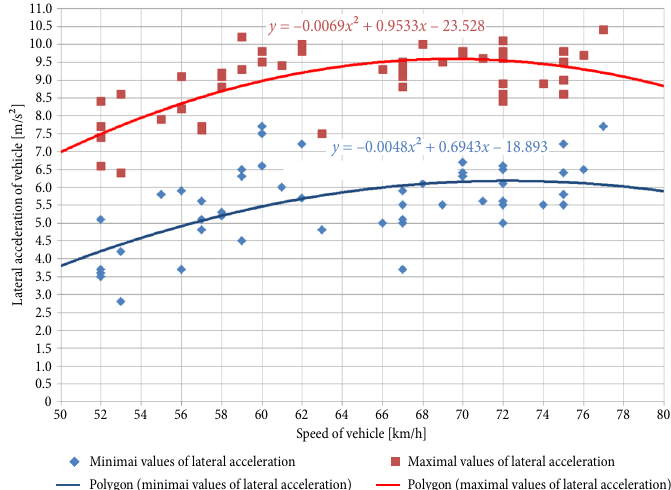
Speed of vehicle [km/h] Maximal values of lateral acceleration Polygon (minimai values of lateral acceleration) Polygon (maximal values of lateral Fig. 3. Achievable lateral acceleration values depending on the speed of a Volvo V40 T5 AWD Cross Country vehicle equipped with the driving stability control system on dry asphalt surface (Panáček 2015)